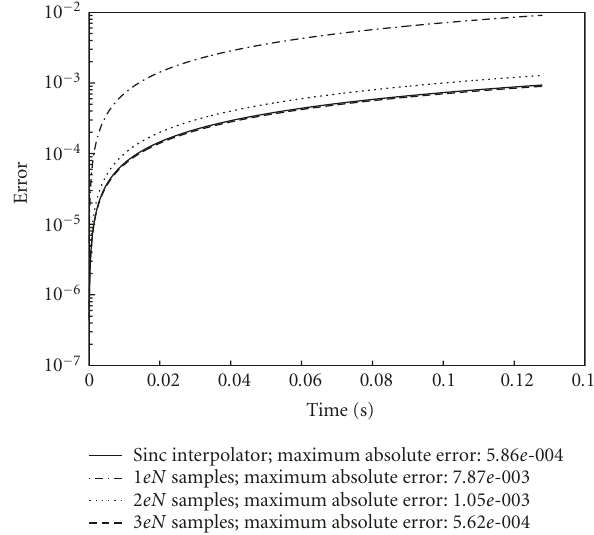
Figure 6: Error trend over time for three di ff erent oversampling factors and a sinc interpolator. Test signal: sparrow chirp, 16bits, 16000 Hz, 2048